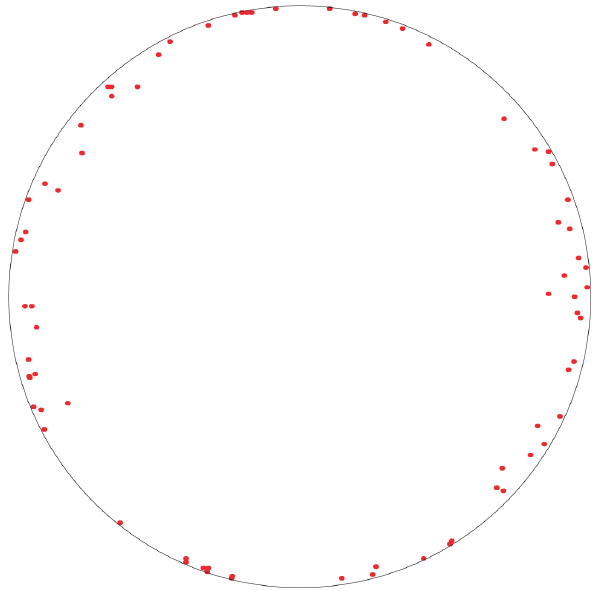
Figure 5. A typical Schmidt equal area net pole projection drawn on the basis of grain